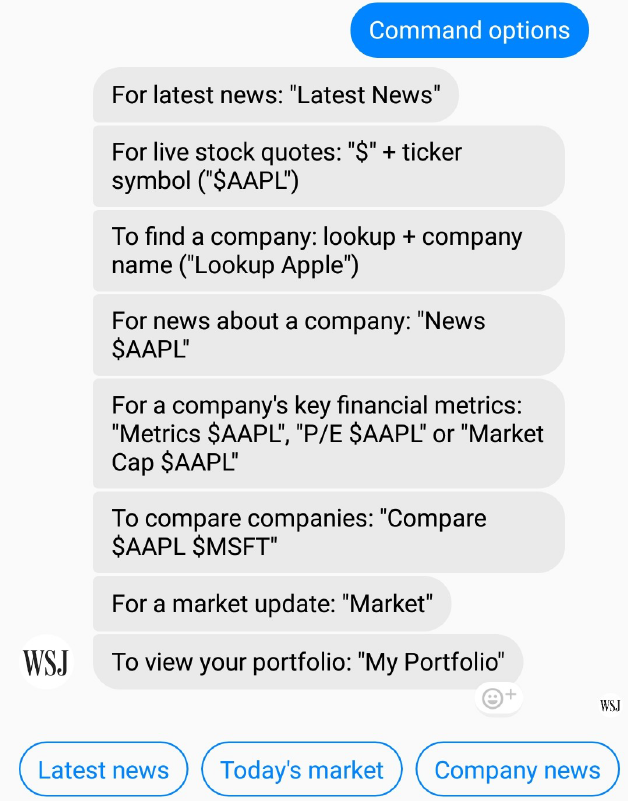
Fig. 15. WSJ’s command list on mobile